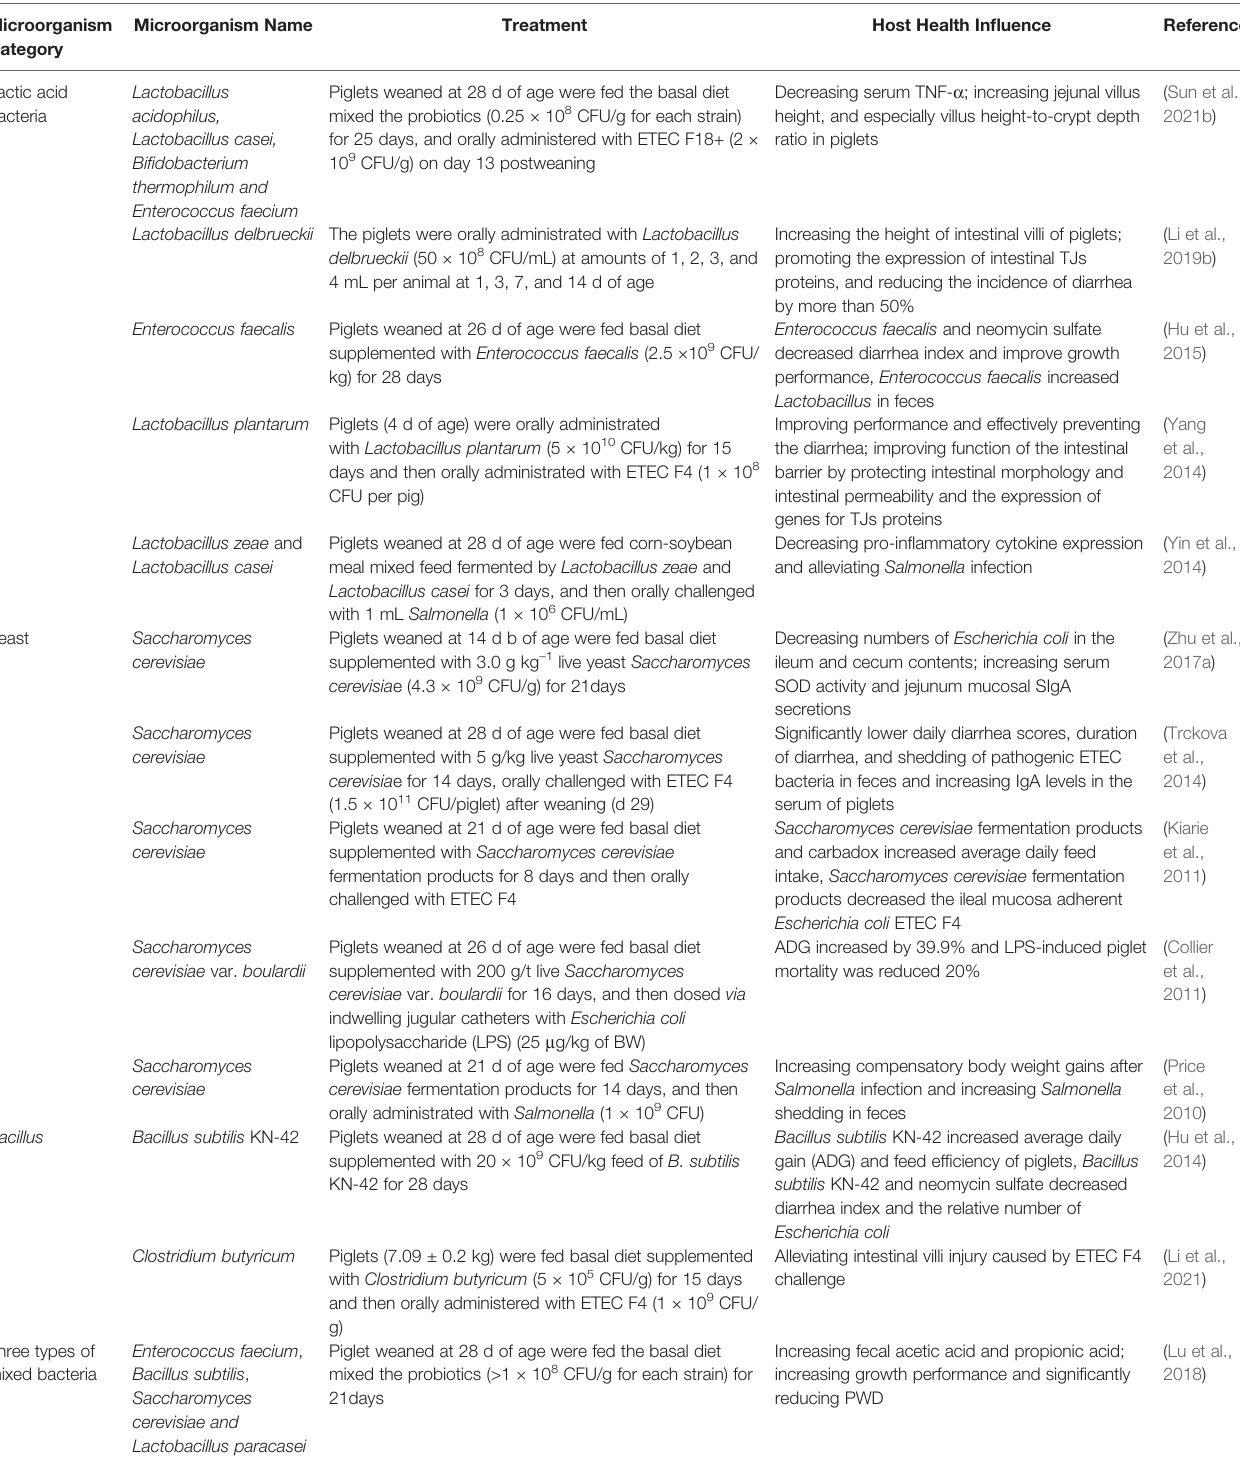
TABLE 1 | Effects of probiotics on treating PWD of